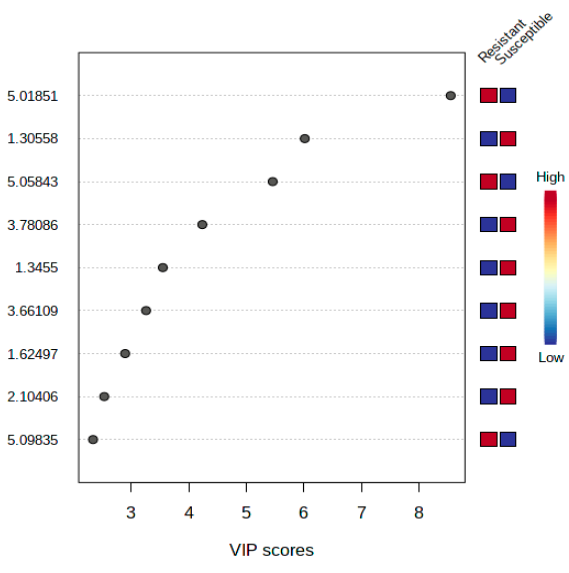
Figure 6. Variable Importance in Projection (VIP) of the metabolites in the top nine by the highest concentration.